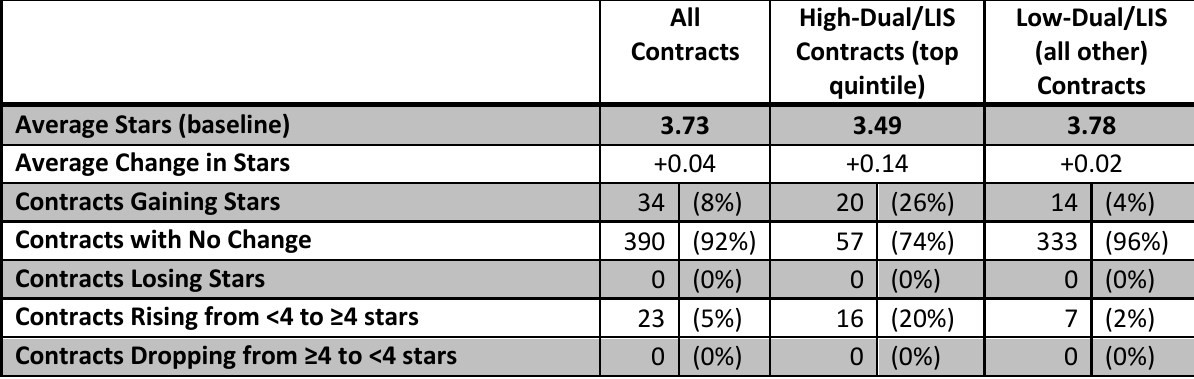
Table 8.16: Targeted Star Adjustment for Improvement for Contracts below 4